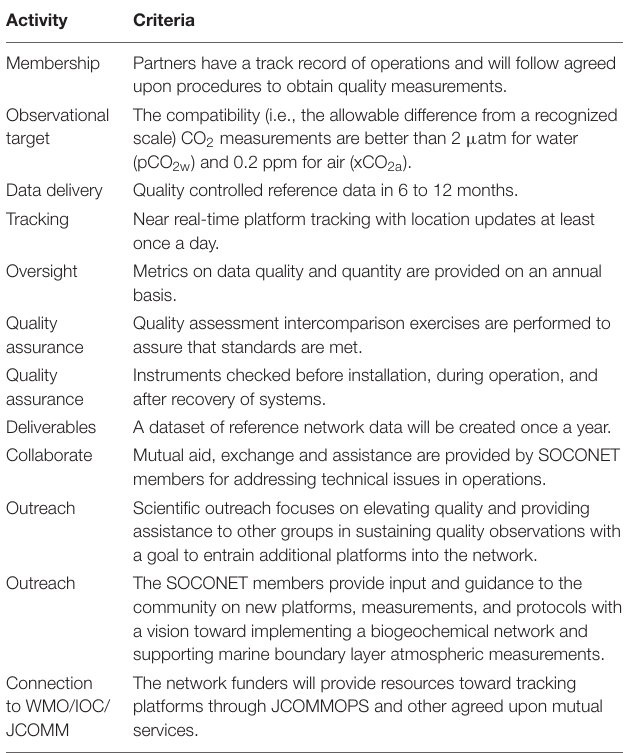
TABLE 3 | Synopsis of SOCONET objectives and criteria.